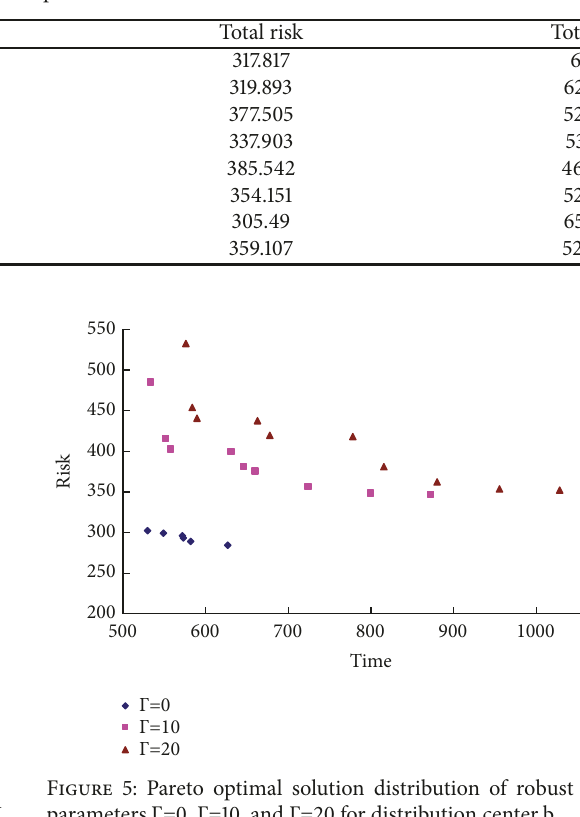
Table 6: Pareto solution set of robust control parameters Γ =10 for distribution center a.